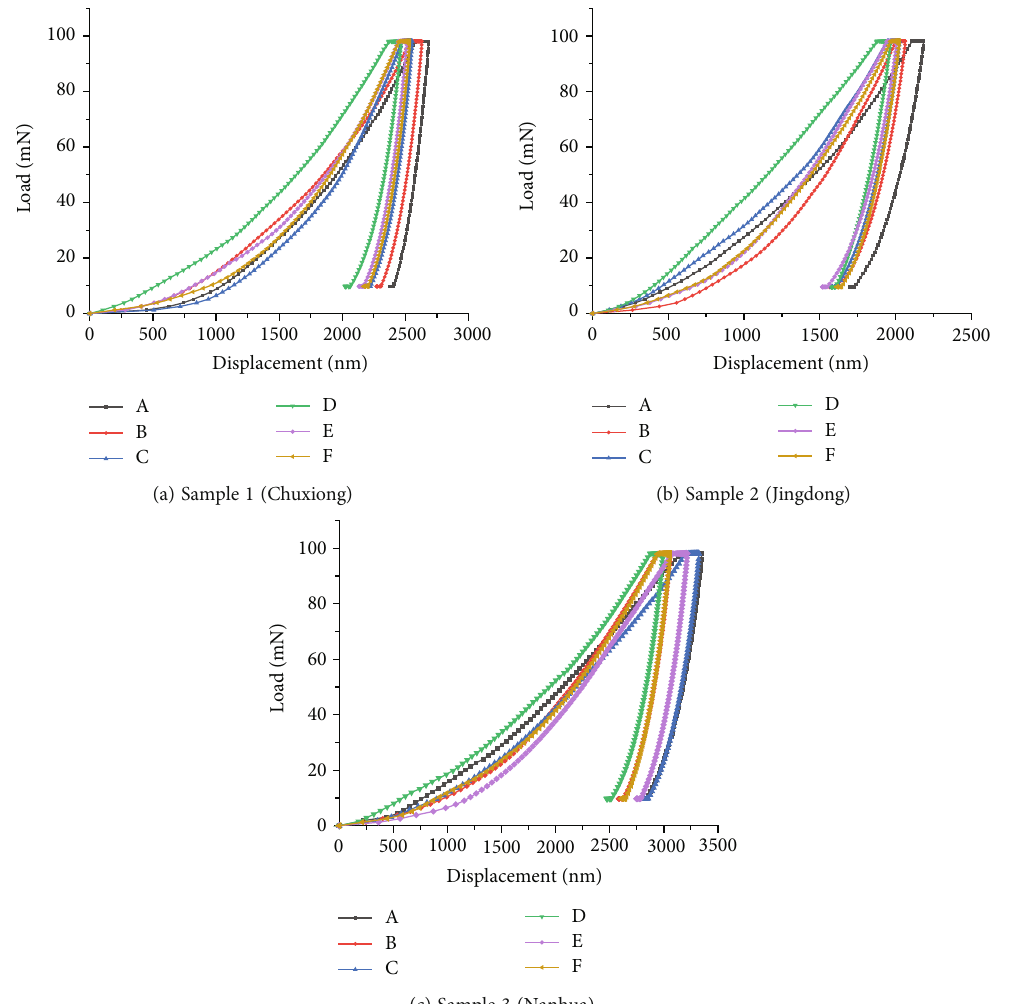
Figure 11: Nanoindentation load-displacement curves of Yunnan red-bed mudstone samples in three